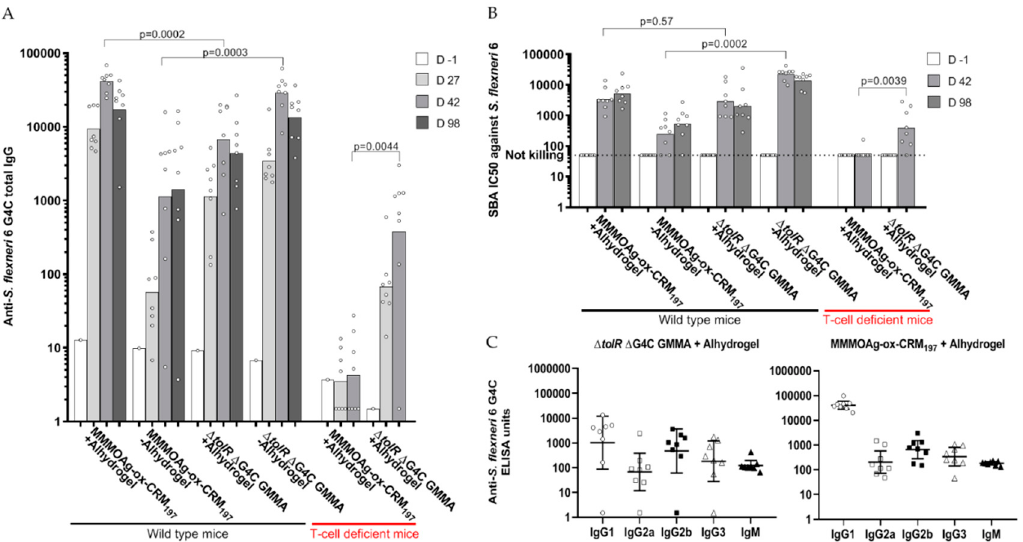
Figure 8. S. flexneri 6 glycoconjugate and GMMA displaying MMM OAg compared in mice. Eight mice per group were subcutaneously immunized at days 0 and 28, with 1 µ g OAg dose with or without Alhydrogel. Anti-OAg specific IgG geometric mean units (bars) and individual antibody levels (dots) ( A ); SBA titers of single sera against S. flexneri serotype 6 strain ( B ); IgM and IgG subclasses analysis of single sera at day 42: individual antibody levels (dots) and geometric means (horizontal lines) ( C ).